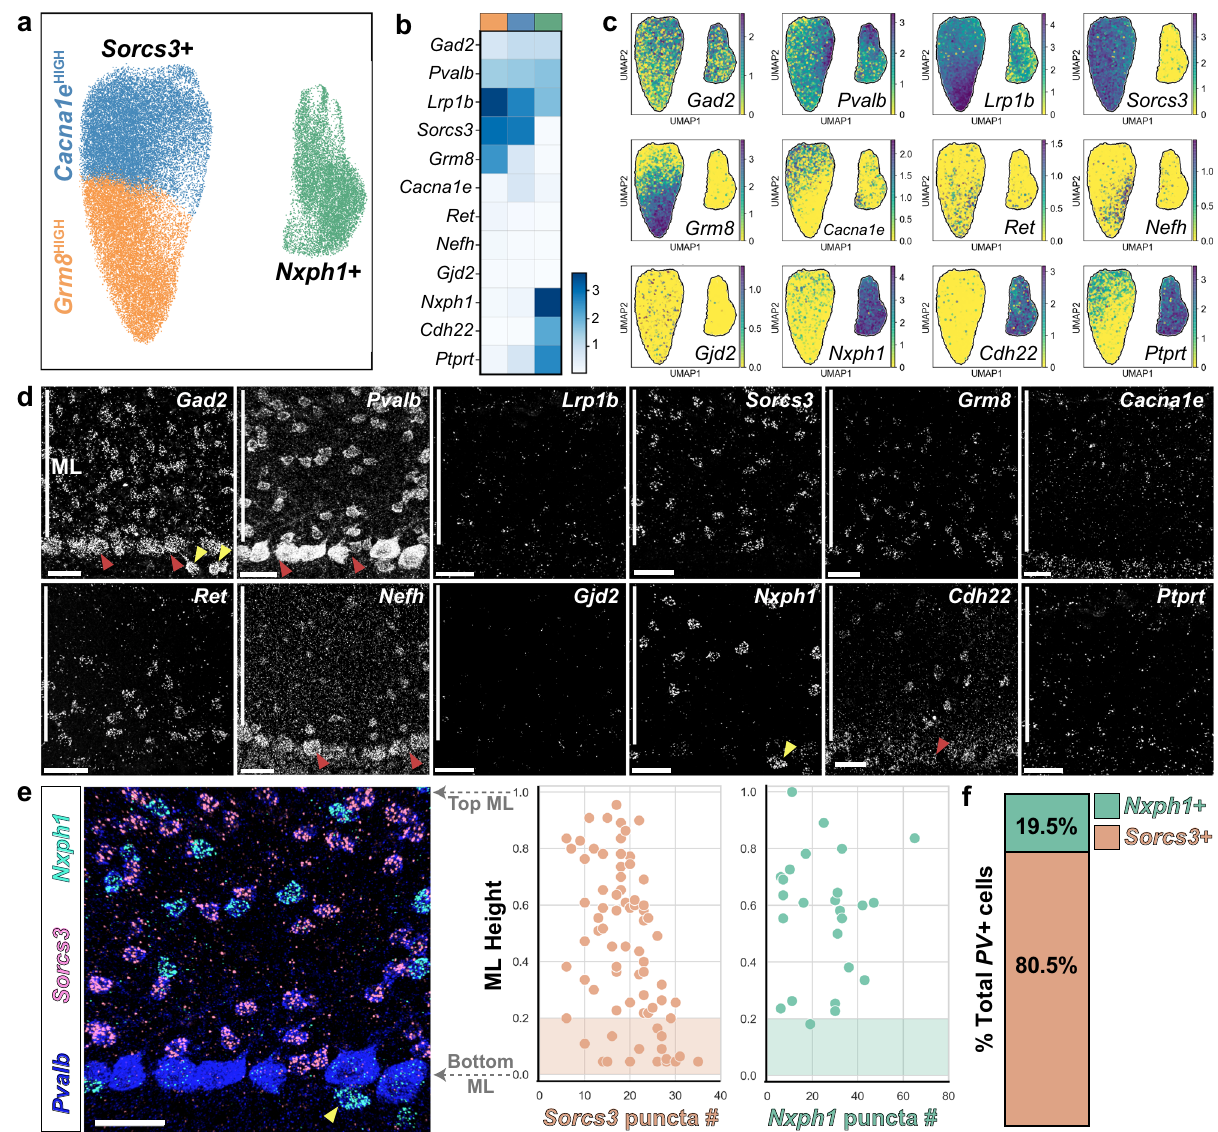
Fig. 4 Clustering and in situ analyses of mature MLI transcriptional signatures reveal discrete and laminar organization of MLI t-types. a UMAP showing 43,479 MLIs separating into two clusters ( Sorcs3 + and Nxph1 + ) based on public single nuclei-extracted RNA sequencing data 51 . The Sorcs3 + cluster subdivides into Grm8 HIGH and Cacna1e HIGH subclusters. b MatrixPlot showing the scaled expression level for transcripts of interest among transcriptional subtypes, Sorcs3 + ; Grm8 HIGH (orange column), Sorcs3 + ; Cacna1e HIGH (blue column), and Nxph1 + (green column). c Transcript levels projected onto UMAP. d smFISH images of MLI transcripts within the cerebellar cortex (ML marked by white bars). Red and yellow arrowheads mark Purkinje cells and Purkinje layer interneurons, respectively. N = 2 – 6 animals. e Left, three-color smFISH for Pvalb (blue) , Sorcs3 (magenta), and Nxph1 (cyan). Sorcs3 and Nxph1 are expressed in non-overlapping cells within the ML. Nxph1 + cells observed below the Purkinje cell layer are likely Purkinje layer interneurons (yellow arrowheads). Right, MLI smFISH quanti fi cation and mapping show that Sorcs3 + cells are distributed throughout ML while Nxph1 + cells are enriched in the upper 80% of the ML ( n = 95 total MLIs from two animals). f Pvalb + cells are either Nxph1 + (green) or Sorcs3 + (orange). Scale bars are 30 µ